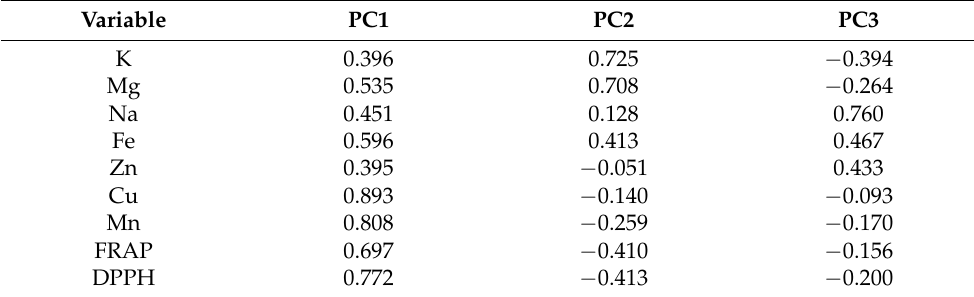
Figure 2. Projection of variables ( a ) and projection of cases ( b ) depending on the botanical origin of the honey in a two-factor plane (PC1 × PC2). ( a ) K, potassium; Na, sodium; Mg, magnesium; Fe, iron; Zn, zinc; Mn, manganese; Cu, copper; DPPH, scavenging capacity; FRAP, ferric reducing antioxidant power; ( b ) honey type: RS, rapeseed; BW, buckwheat; LI, linden; AC, black locust; MF, multifloral. Table 4. Correlations between the principal components and the original